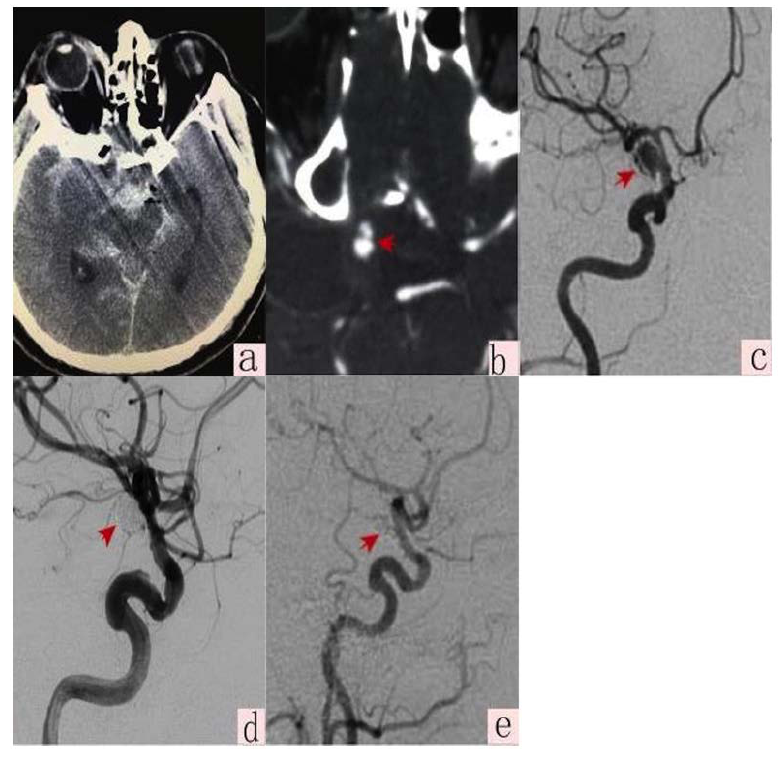
Figure 1. Right internal carotid artery end-dissection aneurysm treated with LVIS stent- assisted coil embolization: a. Head CT scan showing a right-sided cavernous sinus hem- orrhage or subarachnoid hemorrhage; b. Cranial CTA showing the double cavity sign; c. Cerebral angiography showing the right internal carotid artery end bulging aneurysmal expansion, with far end vessel stenosis; d. Shows LVIS stent assisted coil aneurysm embolization and immediate cerebral angiography after stenting angioplasty; e. The dis- section aneurysm did not recur four months after cerebral angiography and the disease- bearing vessels are not narrowed either. Note: red arrows show coils in the aneurysmal sac.